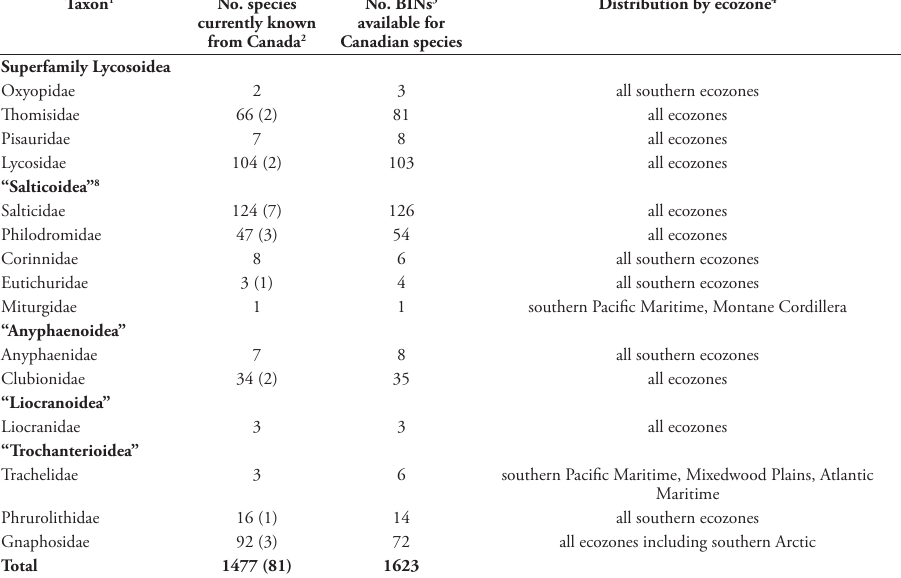
1 Classification follows Wheeler et al. (2017); taxon names in quotation marks are informal. 2 Parentheses enclose numbers of non-native species included in the total. 3 Barcode Index Number (Ratnasingham and Hebert 2013). 4 See figure 1 in Langor (2019) for a map of ecozones. 5 Haplogynae of older classifications. 6 Zodarioidea and all subsequent groups = “RTA Clade”. 7 Dictynoidea of older classifica- tions. 8 “Salticoidea” and all subsequent groups = “Dionycha Clade” (within RTA Clade).